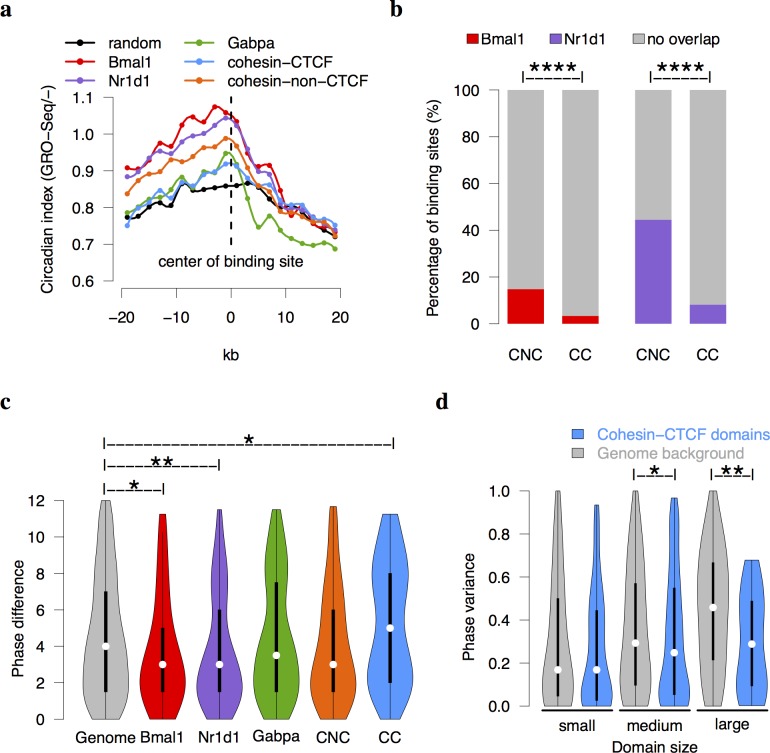
Global analysis of cohesin and CTCF on circadian transcription.(a) The distribution of circadian rhythmicity of transcription around the protein binding meta-sites (Methods). The circadian index was defined from the negative strand of GRO-Seq [9]. The result from positive strand was shown in S3A Fig. The data points are connected by spline smoothing method. The circadian rhythmicity is high around Bmal1, Nr1d1, and cohesin-non-CTCF sites but not around cohesin-CTCF sites. (b) Both Bmal1 and Nr1d1 binding sites have significantly higher overlaps with cohesin-non-CTCF sites (CNC) than cohesin-CTCF (CC) sites in mouse liver (Fisher’s exact test p = 10−16). (c) The distributions of phase differences of neighboring COGs are shown in a violin plot. The phase differences across Bmal1 and Nr1d1 binding sites are significantly smaller than the genomic background, whereas the phase differences across cohesin-CTCF sites are larger than the genomic background (Mann-Whitney U test). (d) The violin plot of phase variance in cohesin-CTCF domains. The medium and large cohesin-CTCF domains inferred from cohesin ChIA-PET data [29] have smaller phase variances than the background domains (Mann-Whitney U test). ****p < 10−8,**p < 0.01, *p < 0.05.